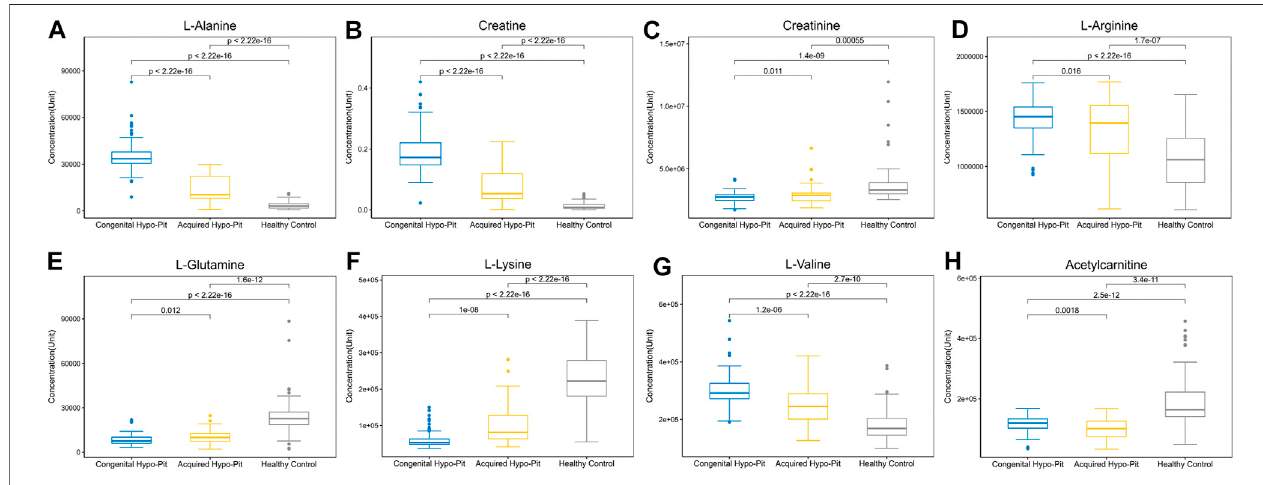
FIGURE 4 | The expression pattern of typical differential metabolites.